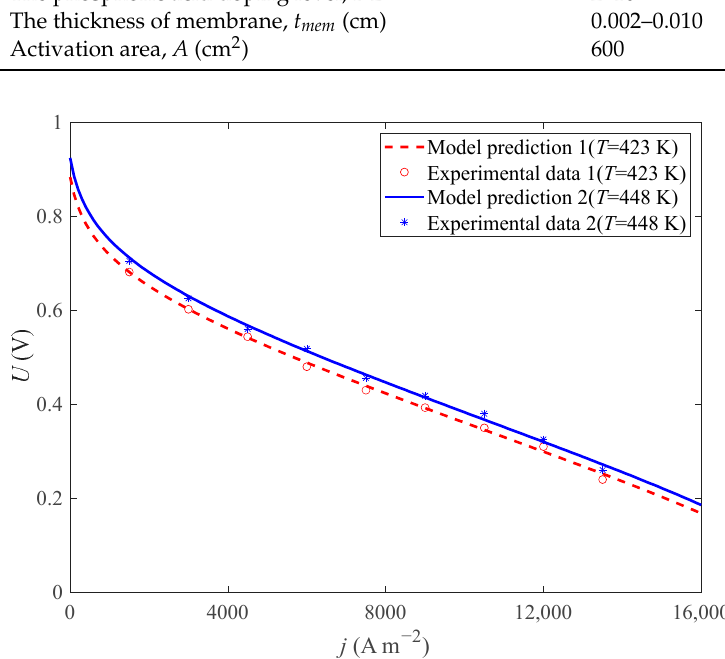
Figure 2. Comparison of experimental and simulation results under different 𝑇 .